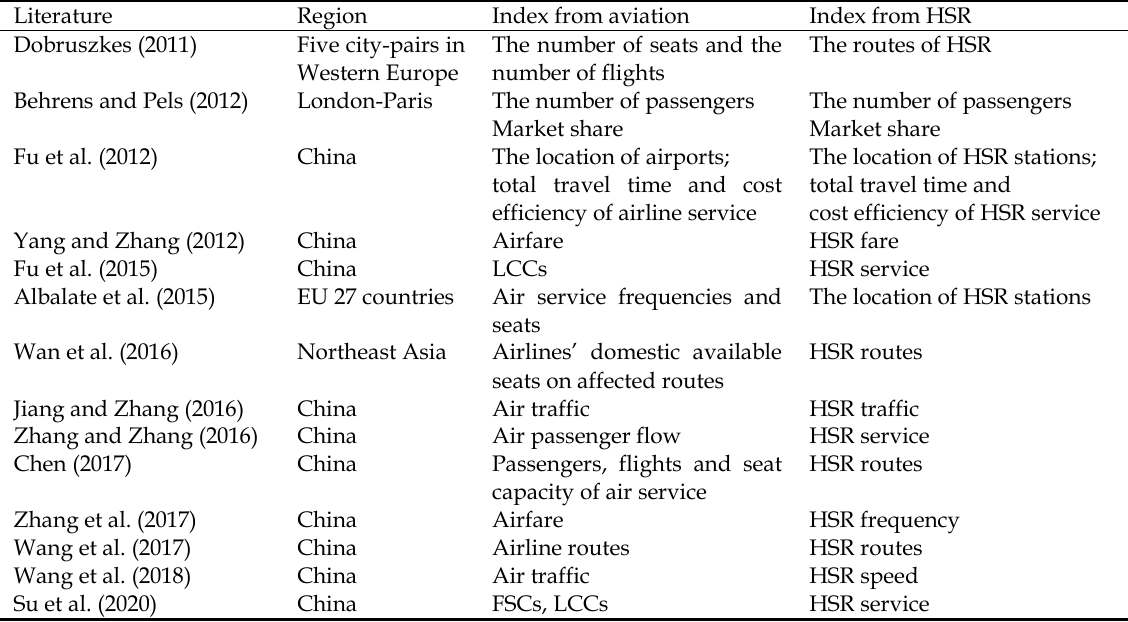
Summary of Indexes from Air-HSR interaction